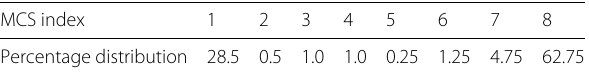
Table 2 Distribution of the output